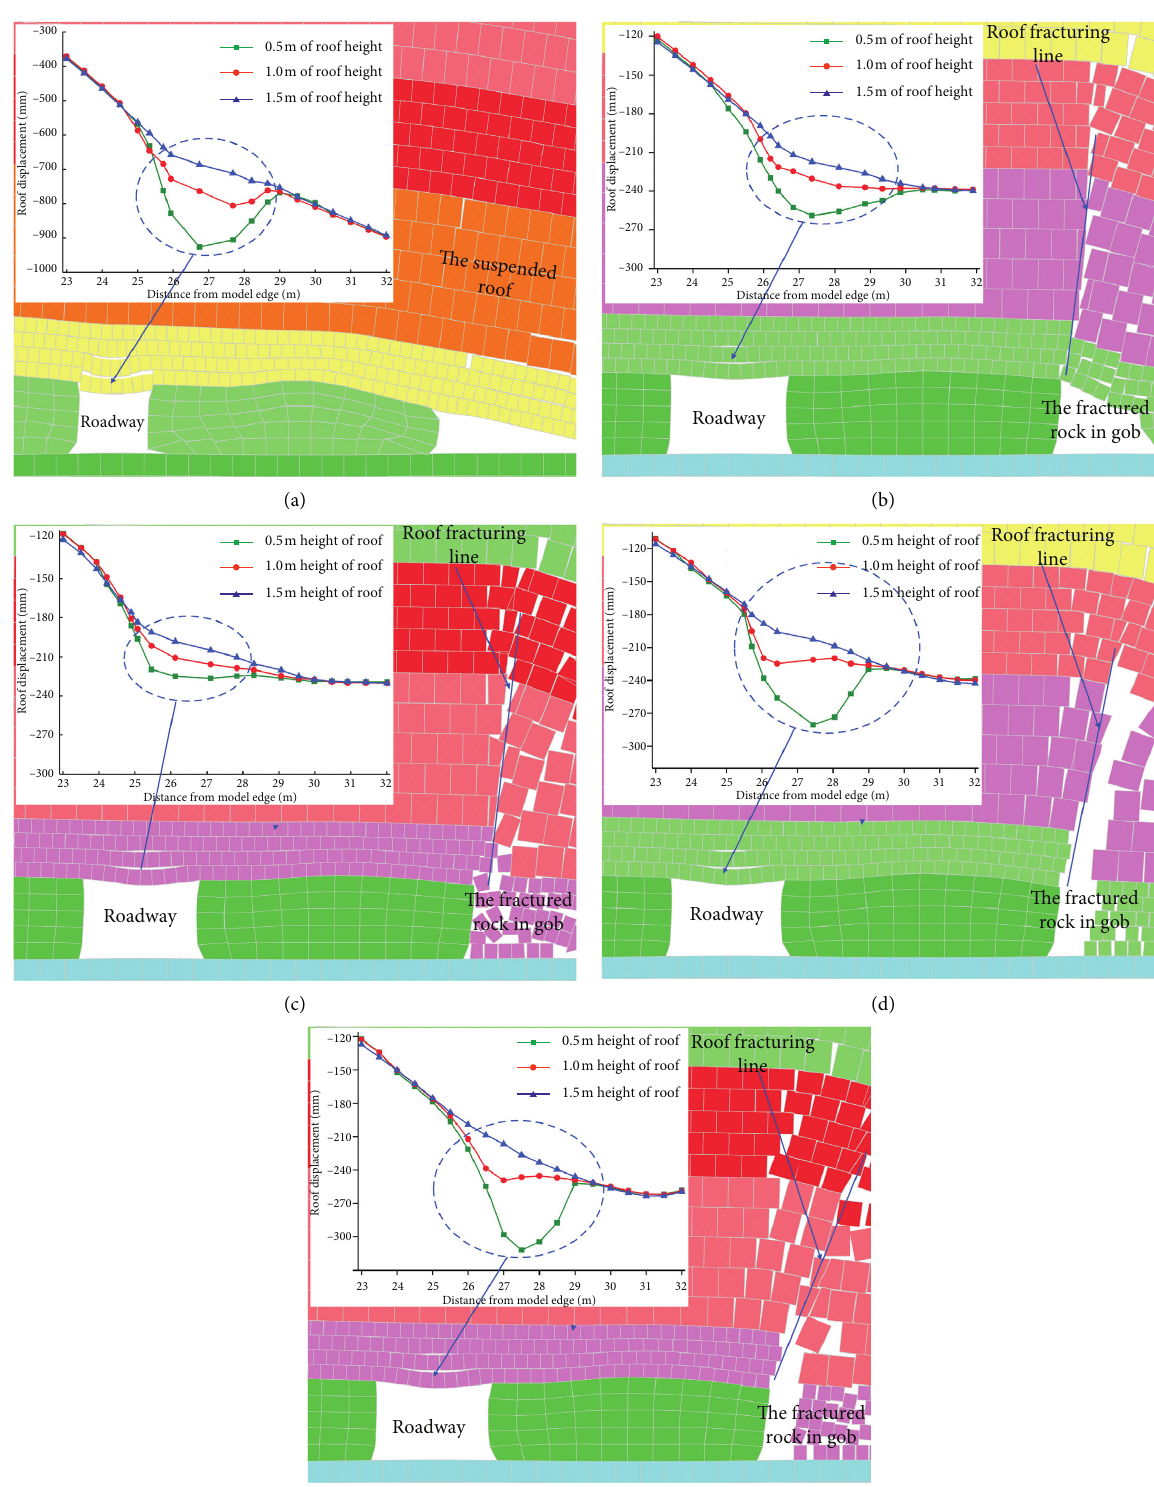
Figure 12: The deformation rules and fracture characteristics of roof strata under different roof fracturing conditions. (a) Nonfracturing roof. (b) 5 ° roof fracturing angle. (c) 10 ° roof fracturing angle. (d) 15 ° roof fracturing angle. (e) 20 ° roof fracturing